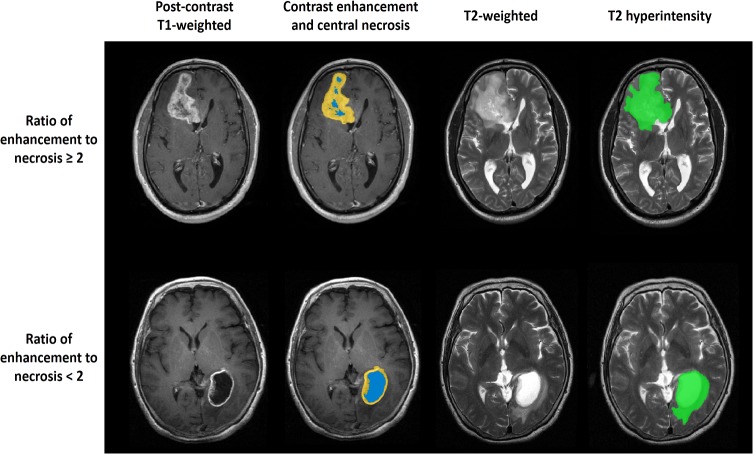
Anatomic MR images for anaplastic gliomas with different ratios of enhancement to necrosis (≥ 2 and < 2).The areas of contrast enhancement are marked in yellow; areas of central necrosis are marked in blue; areas of T2 hyperintensity (exclusion of contrast enhancement) are marked in green.